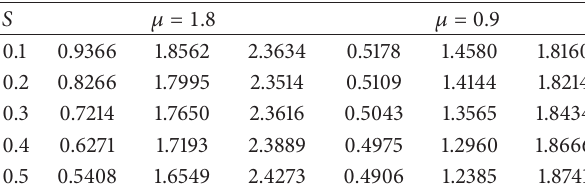
Table 1: First three nondimensional natural